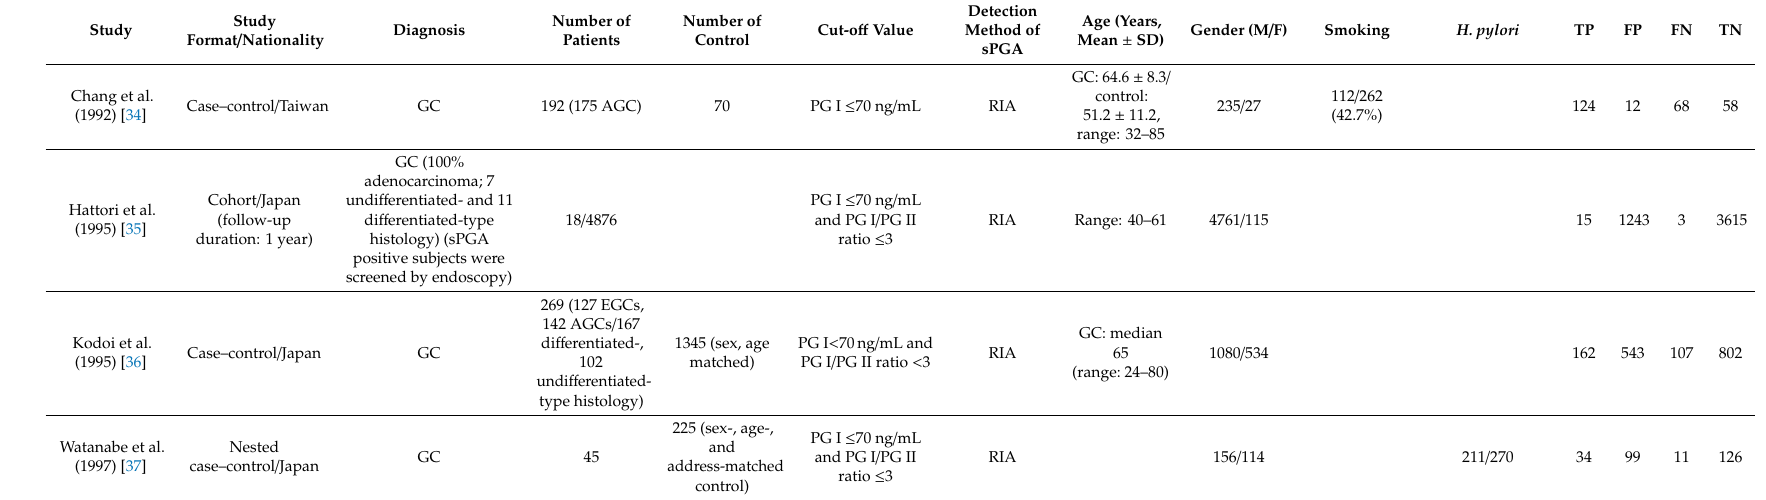
Table 4. Clinical characteristics of the included studies for the diagnosis of